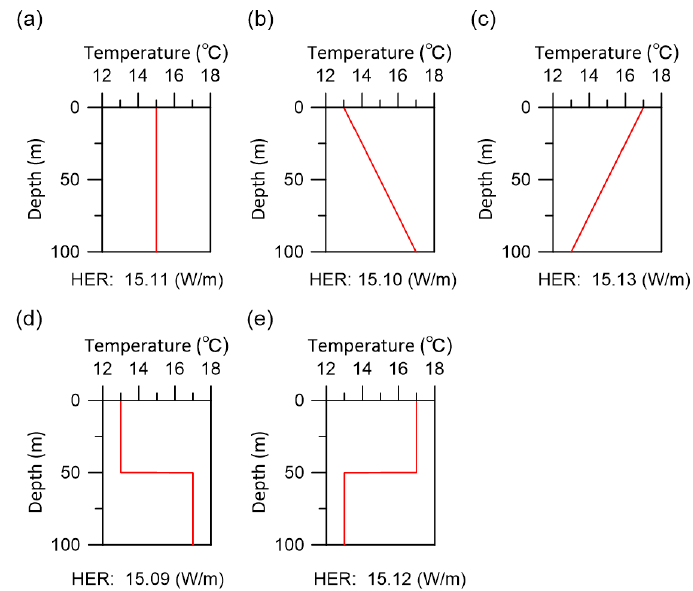
Figure 8. Distribution of the subsurface temperature profile and GHE simulation result of the model. The temperature profile was set as ( a ) 15 ◦ C, ( b ) with a temperature gradient of 0.04 ◦ C / m, ( c ) temperature gradient of − 0.04 ◦ C / m, ( d ) 13 ◦ C from top to 50 m depth and 17 ◦ C from 50 to 100 m depth, and ( e ) 17 ◦ C from top to 50 m depth and 13 ◦ C from 50 to 100 m depth. The arithmetic average value of all these profiles was 15 ◦